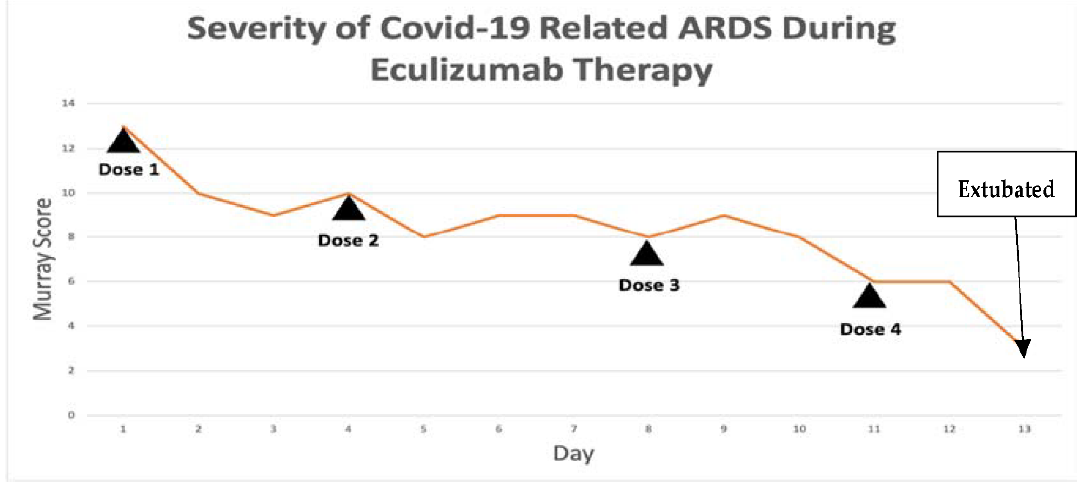
Figure 3. Severity of COVID-19-related ARDS over time during Eculizumab therapy for patient A1.